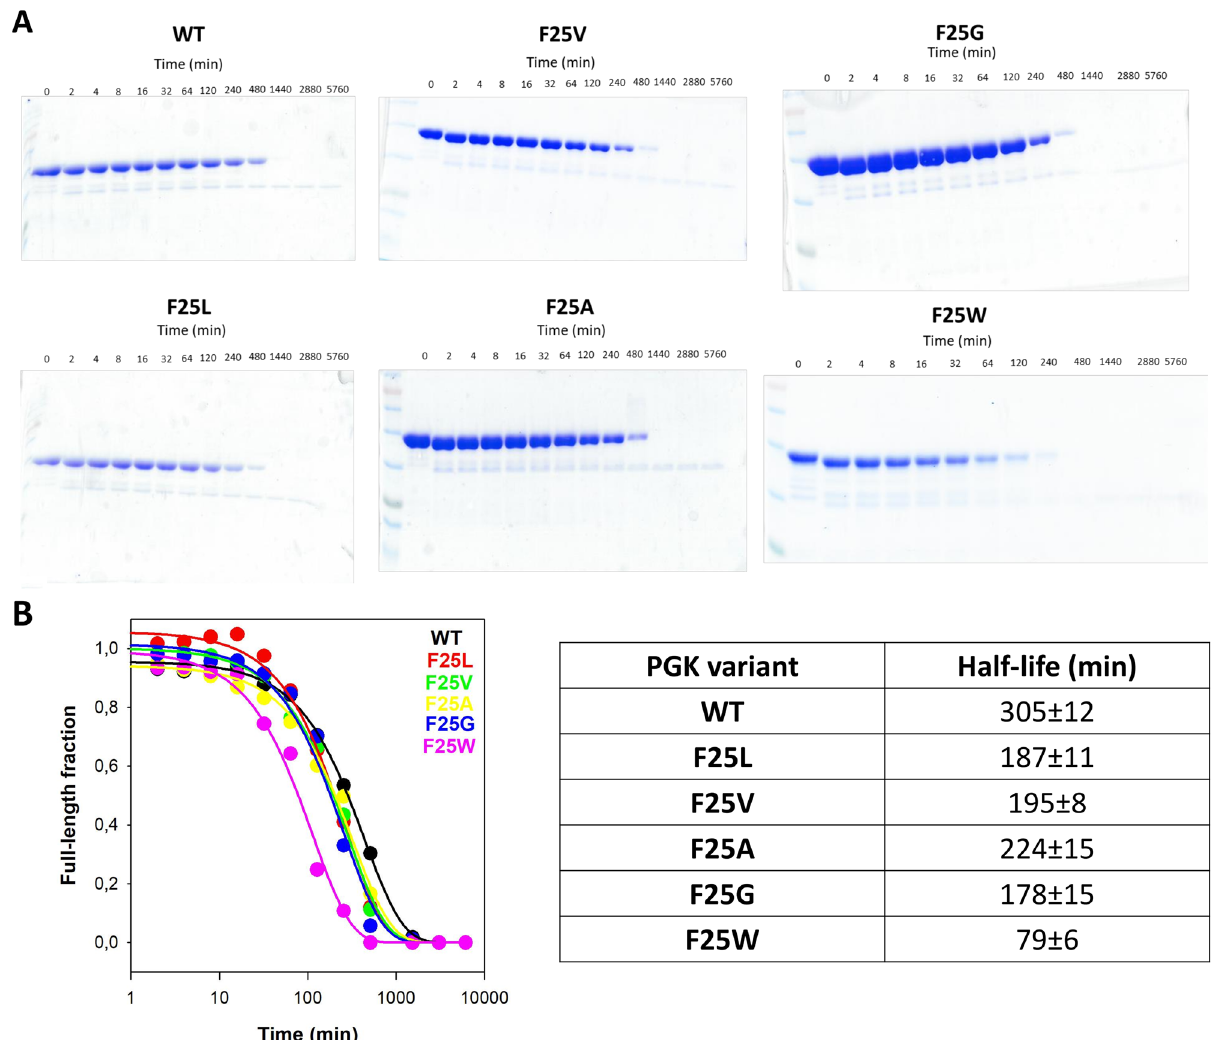
shown in panel A with fittings to a single exponential function (left panel) and the corresponding half-lives (right panel). Thermolysin concentration was 1 µM. Experiments were carried out in 20 mM HEPES–NaOH 200 mM NaCl, pH 7.4 at 25